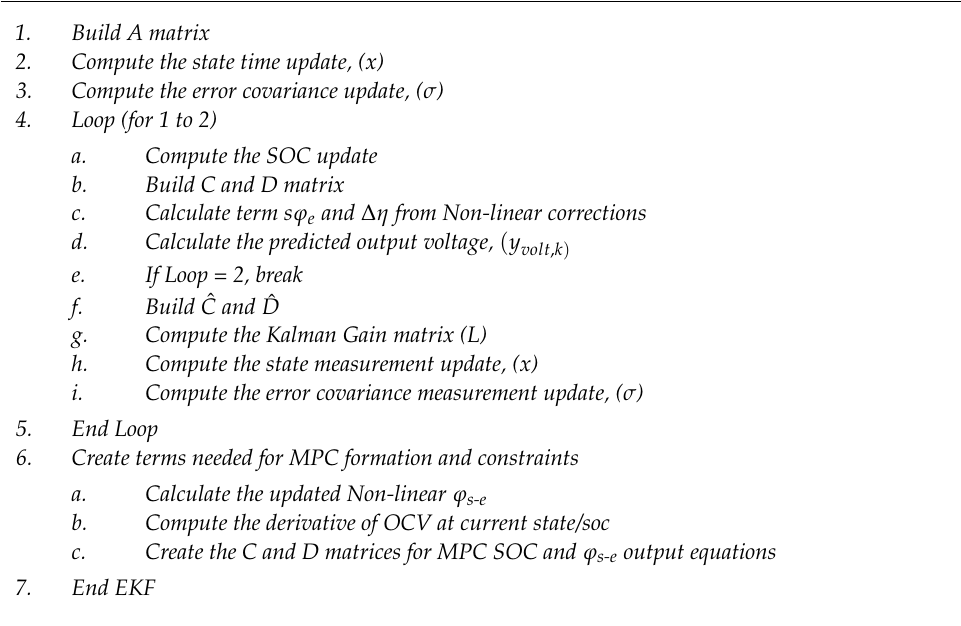
Algorithm 8: Functional Flow of Extended Kalman